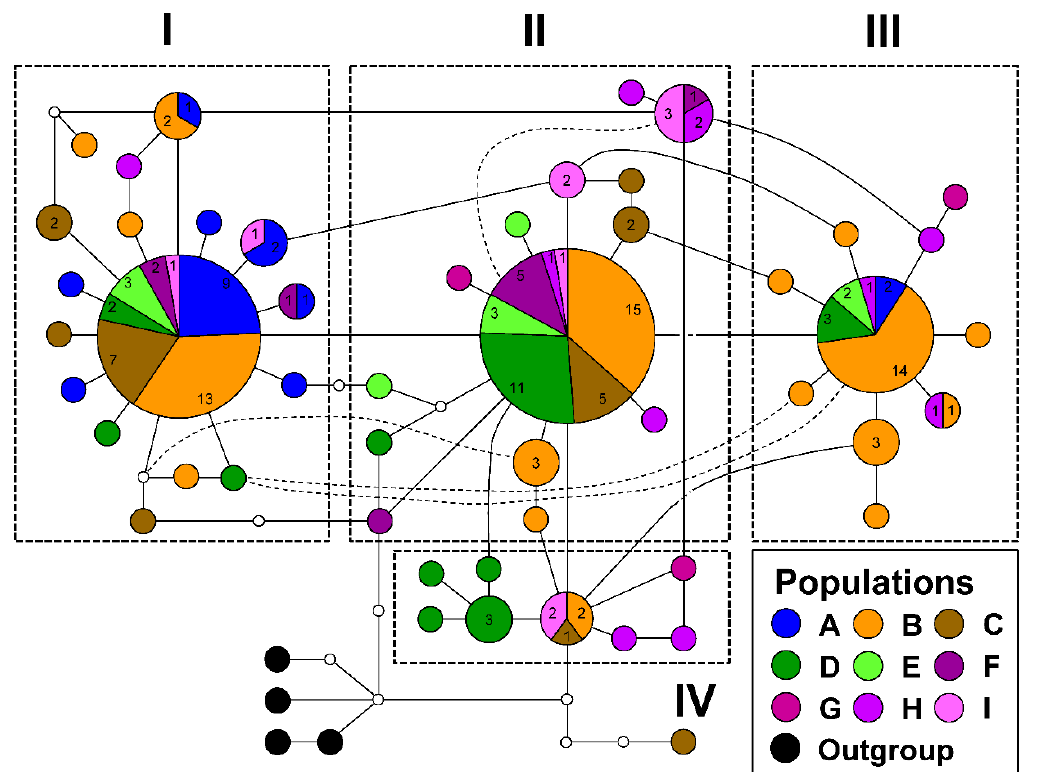
Figure 4. Haplotype network of the hilly lineage of NSC based on 16S rRNA gene. Haplogroups I to IV are grouped based on the phylogenetic inference. Populations are represented by different colors according to Figure 1. Four individuals from the montane lineage are rooted. Each circle represents a haplotype, and the circle size is proportional to the number of individuals. The smallest circle corresponds to one individual, and the number of individuals of each population is marked on the corresponding circle.